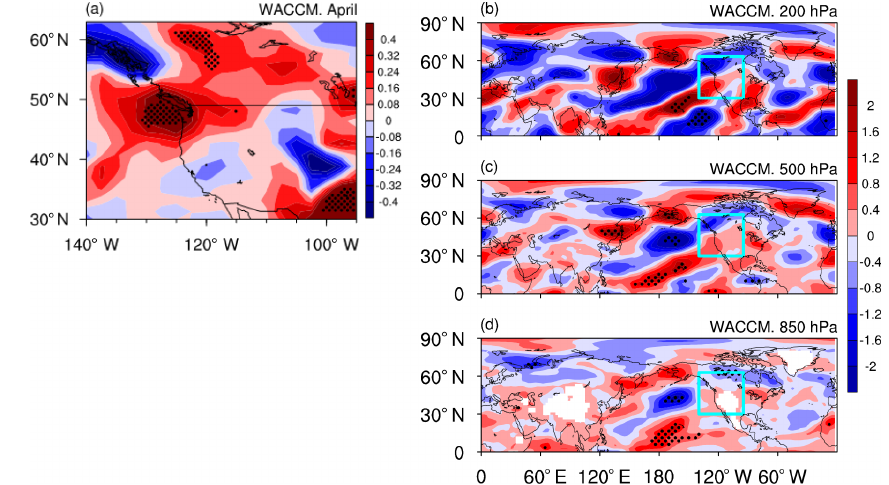
Figure 7. Differences between experiments R3 and R2 in terms of April (a) precipitation (mmday − 1 ) and (b–d) zonal wind at 200, 500 and 850hPa, respectively. Dots denote significance at the 95% confidence level.